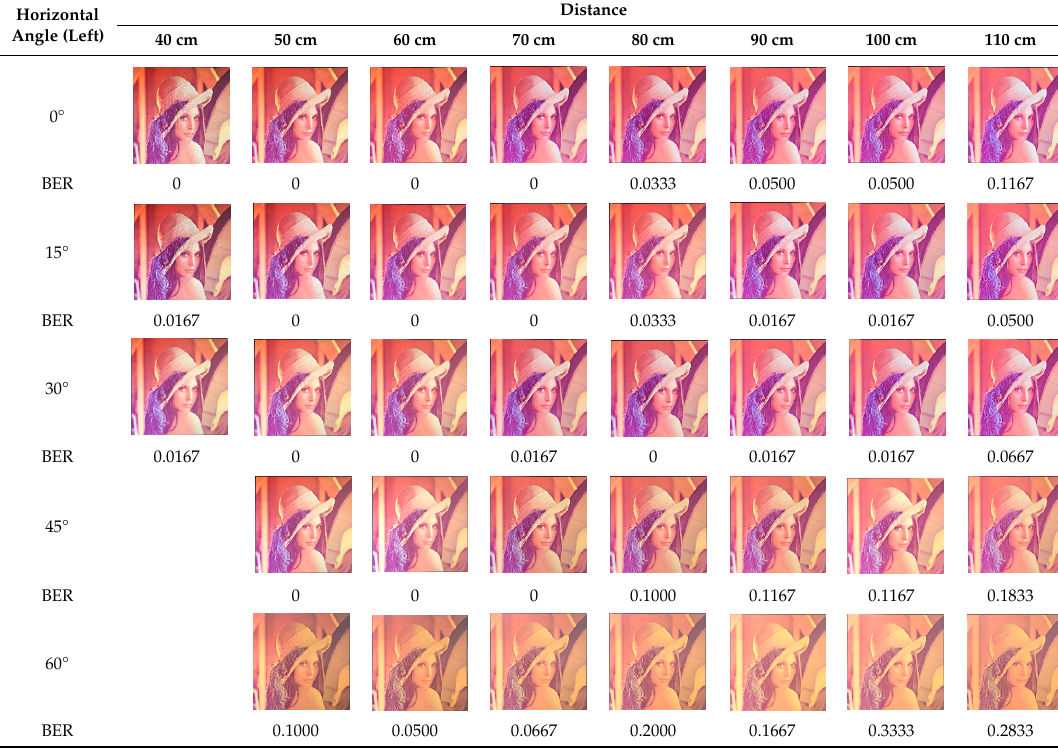
Table 4. Examples of Lena recovered from different captured images.